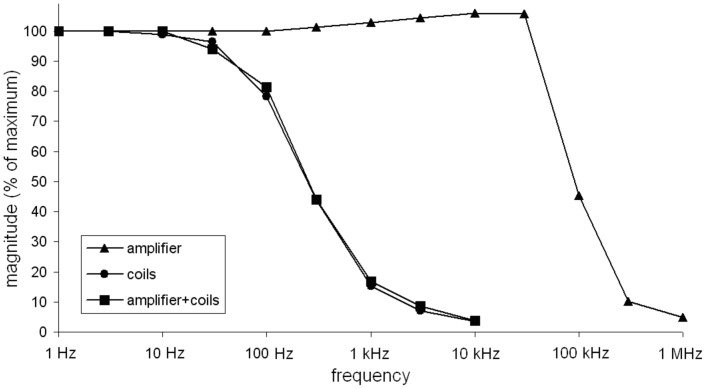
Frequency characteristics of amplifier, coils and amplifier + coils.